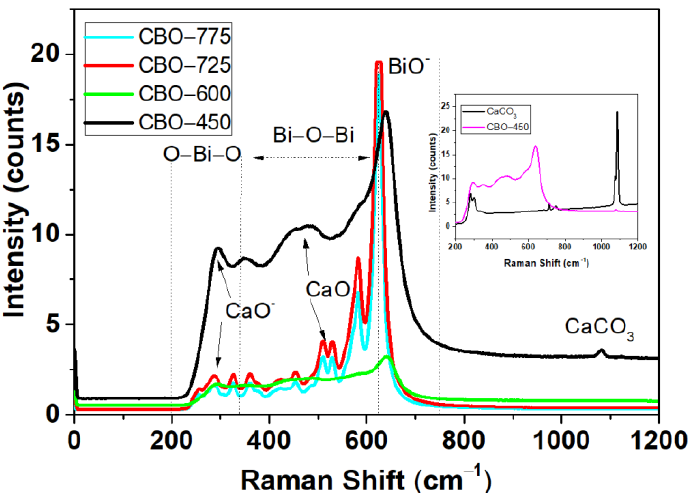
Figure 3. Raman spectra recorded vs. wavelength for the CBO at different temperatures; in the inset is the calcite spectra recorded versus CBO-450.